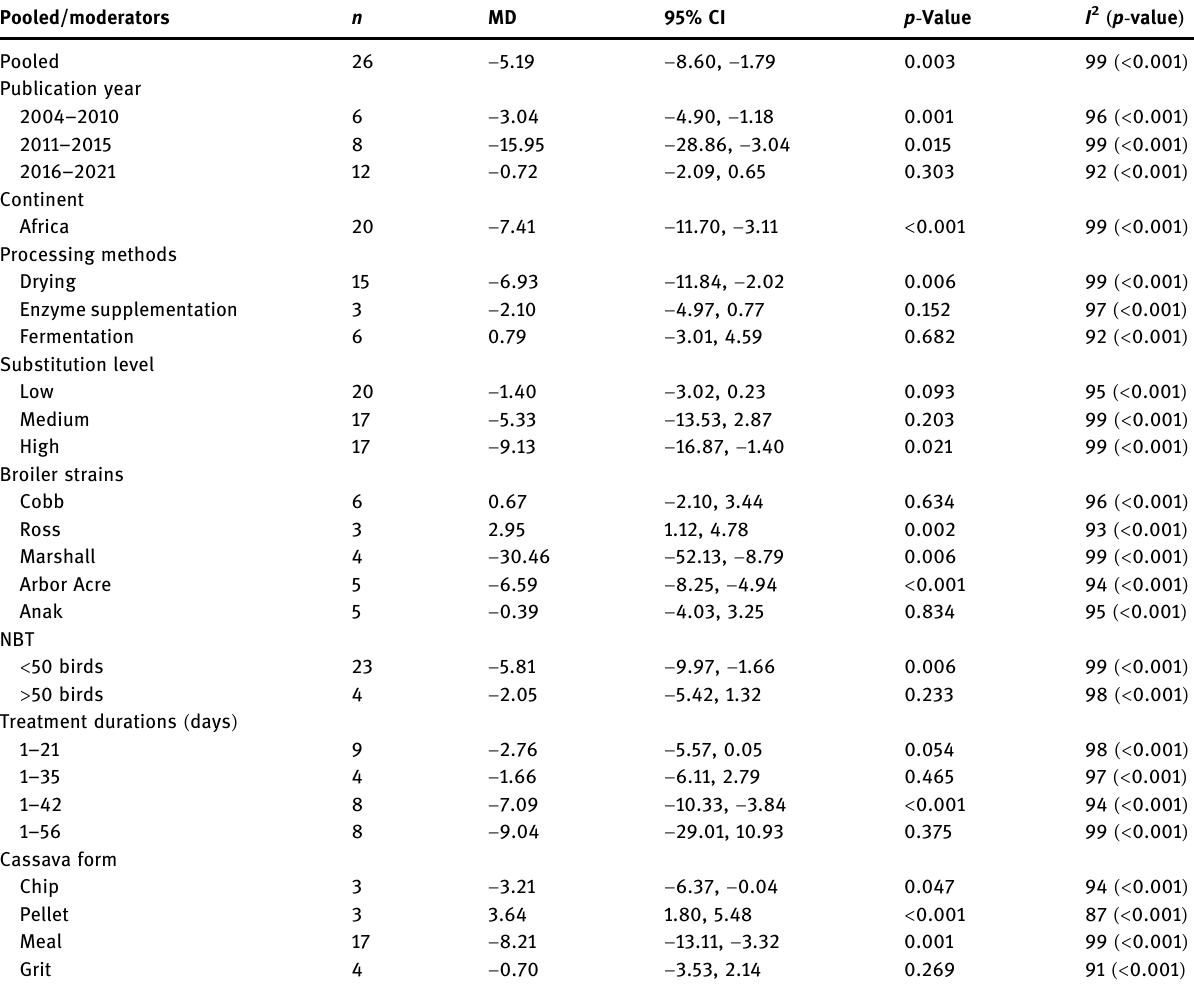
Table 3: E ff ect of cassava on ADFI in broiler chickens